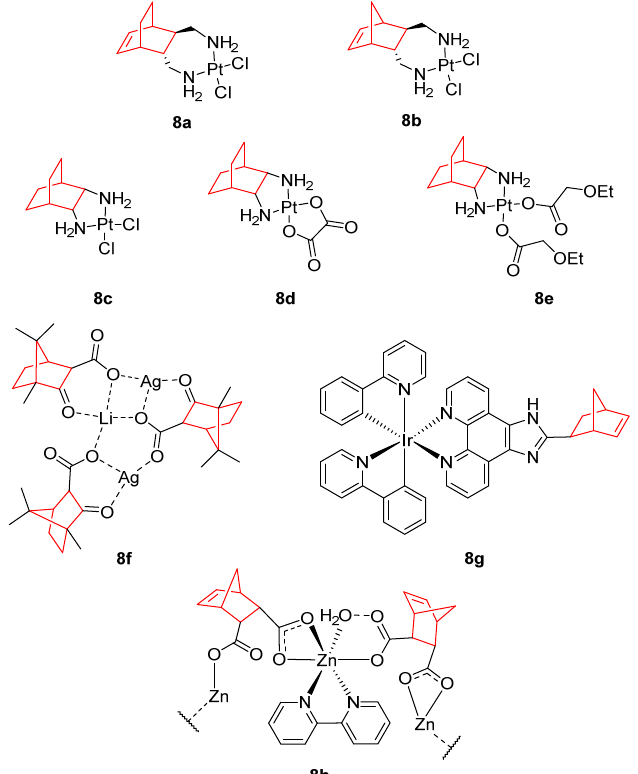
Figure 8. Metal complexes containing a norbornene scaffold and its bicyclo[2.2.2]octane analogue [81–86]. Table 2. IC 50 of different platinum containing bicycles